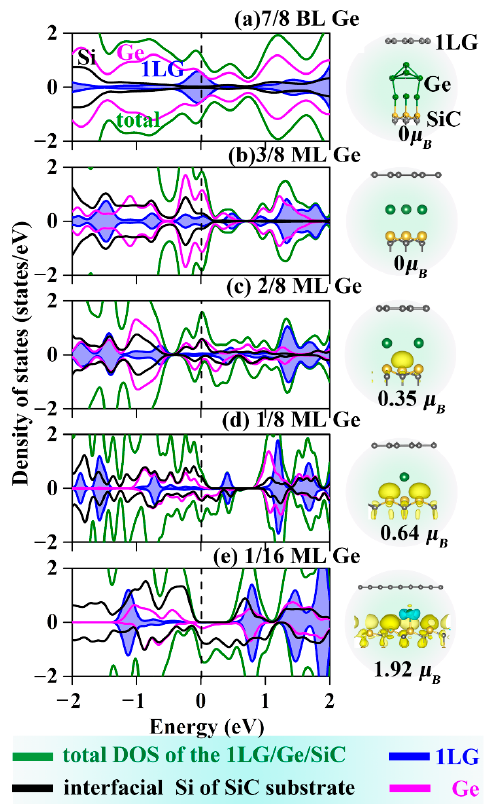
Figure 2. DOSs and spin densities for ( a – e ) 1LG/Ge/SiC with different coverages. Light blue and yellow isosurfaces represent positive and negative spin densities (±0.02 e/Å3), respectively. The green lines represent the total DOS of 1LG/Ge/SiC. The black, pink, and blue lines correspond to the PDOS of interfacial Si of SiC substrate, Ge, and 1LG, respectively.